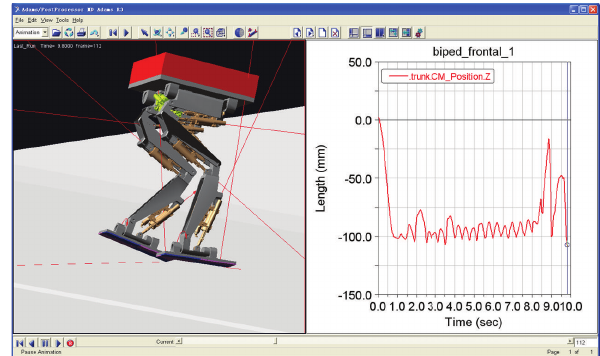
Figure 10: Walking without the balance control method on uneven terrain.